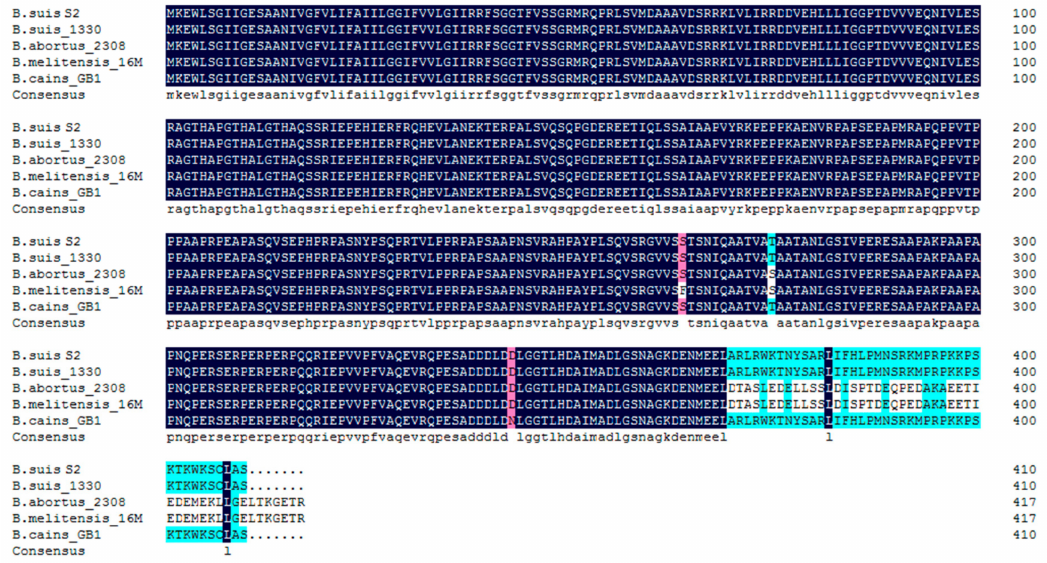
Figure 1. Alignment of VceC nucleotide sequences ( A ) and amino acid sequences ( B ) for Brucella suis S2 (BSS2_I1011), B. suis 1330 (BR1038), B. abortus 2308 (BAB1_1058), B. melitensis 16M (BEMI0948), and B. cains GB1 (C6Y57_05925). Amino acid di ff erences are shaded in red and